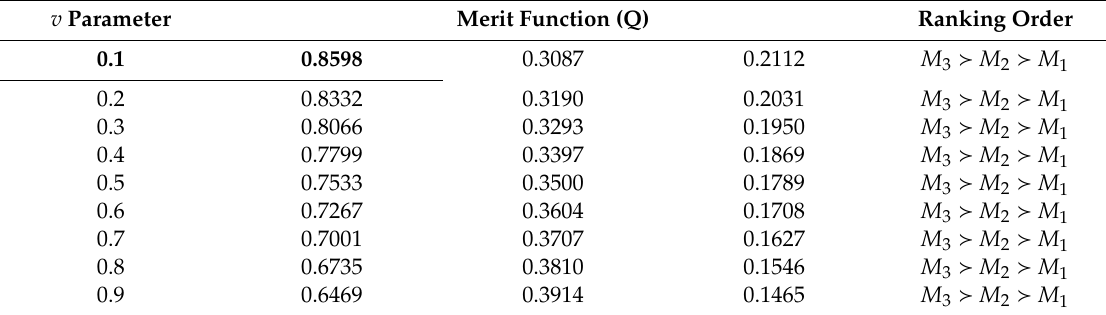
Table 5. Sensitivity analysis for proposed IVPLTS-VIKOR